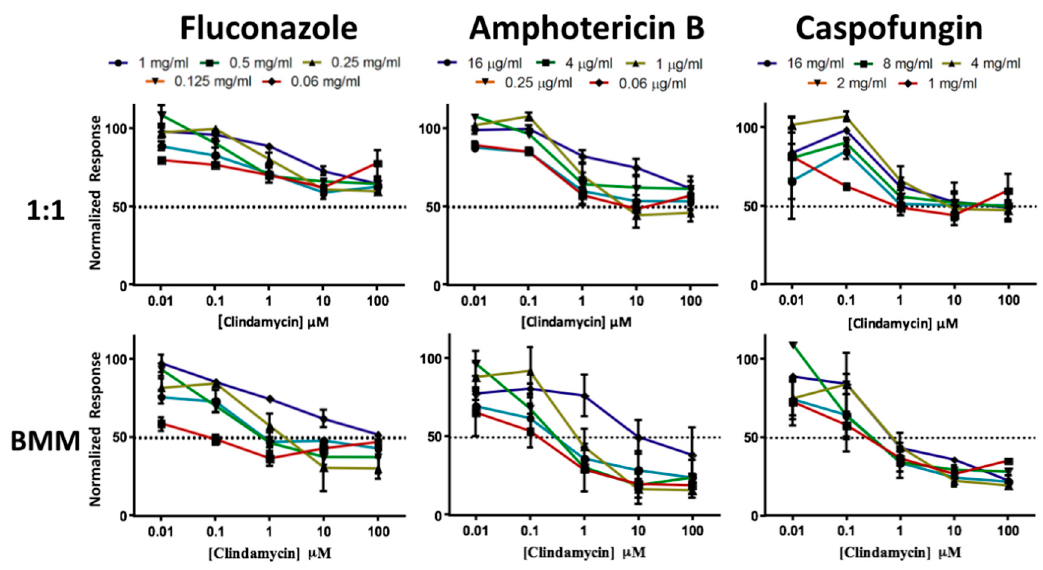
Figure 5. Antimicrobial susceptibility patterns of preformed dual-species C. albicans/S. gordonii biofilms formed in 1:1 v / v RPMI/THB + 0.02% YE media (1:1, upper panels) or BMM synthetic saliva (BMM, lower panels) using an antibacterial/antifungal combination therapy.